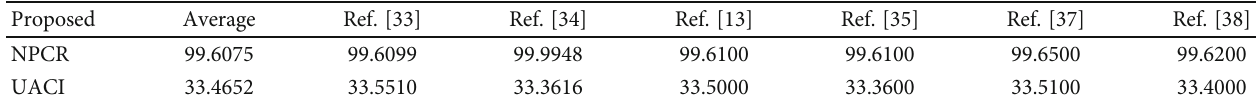
Table 4: NPCR and UACI comparison with other algorithms (%).